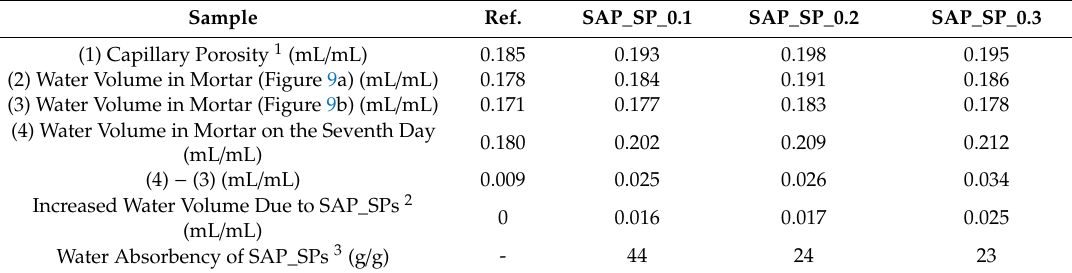
Table 6. Calculation procedure for absorbency of SAP_SP during capillary water uptake in mortar. Sample Ref.